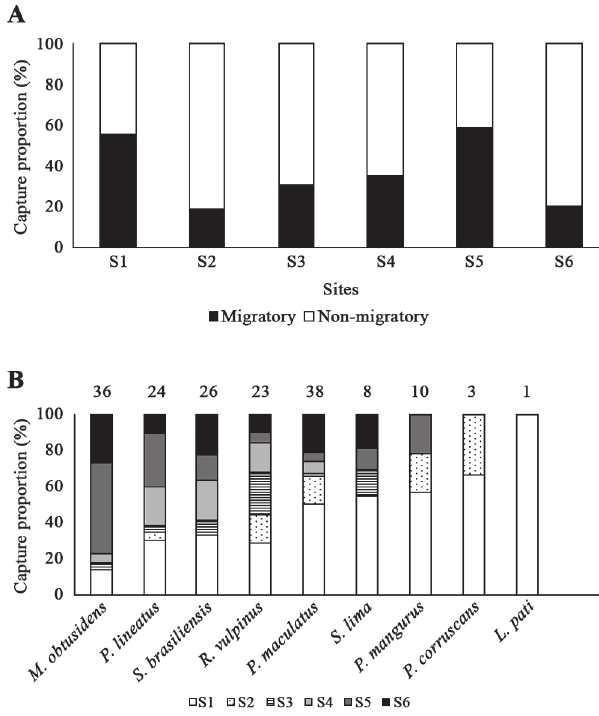
Fig. 4. Relative abundance (% biomass, CPUEb) of migratory fishes at each site (A), and spatial distribution of biomass considering each migratory species (B). The number of individuals captured is indicated above each bar. Characiformes: Megaleporinus obtusidens, Prochilodus lineatus, Salminus brasiliensis and Rhaphiodon vulpinus. Siluriformes: Pimelodus maculatus, Sorubim lima, Pseudopimelodus mangurus, Pseudopplatystoma corruscans and Luciopimelodus pati .